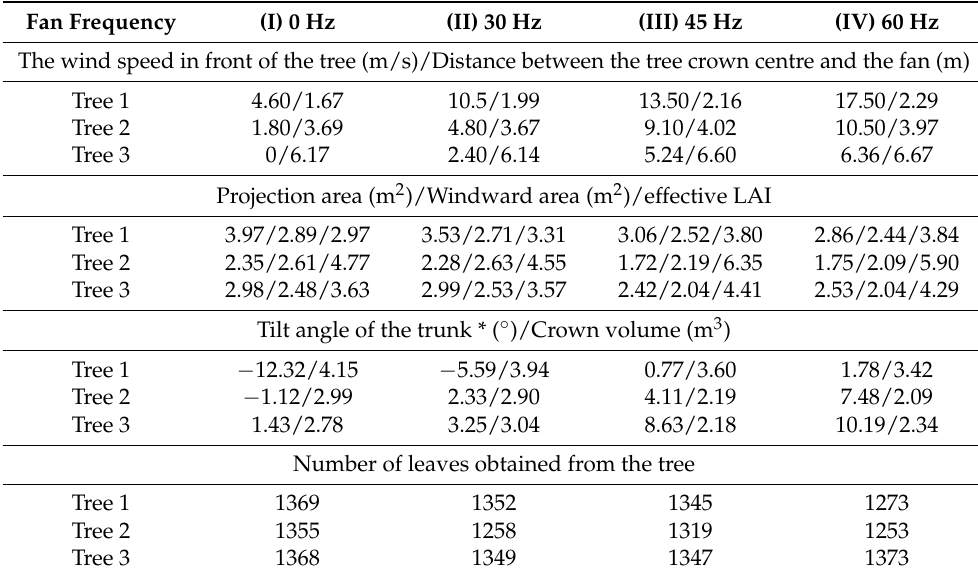
Table 3. Variations in tree phenotypic parameters under the influence of different strong air currents.